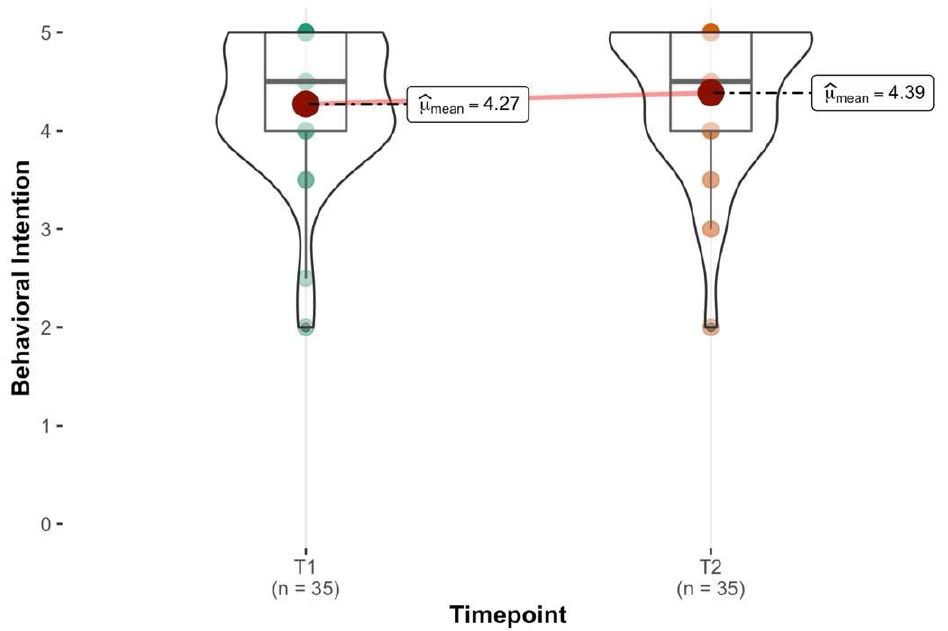
Figure 4. Change in behavioral intention from pre-ride to post-ride. Violin plot illustrating change in behavioral intention from T1.